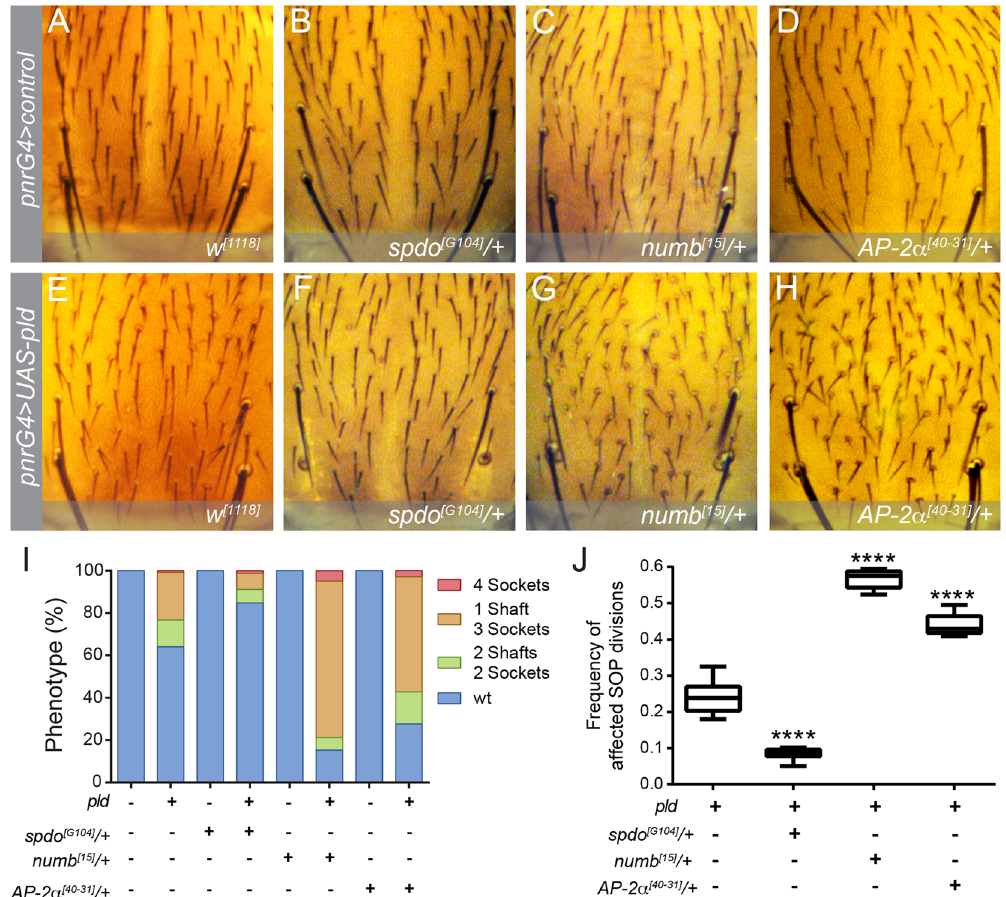
Figure 3. Notch trafficking regulators modify the PLD overexpression phenotype. ( A – H ) Dorsal views of nota on a heterozygous background of different Notch regulators that control the cell-fate in pllb. ( A – D ) Driver control. ( E – H ) Overexpression of PLD. Note that in heterozygous backgrounds there are no changes in the SO cell-fates. ( I ) Frequency of the 4 phenotypes for each case. ( J ) Quantification of the frequency of SOP divisions affected by the gain function of Notch. n = 10, **** p <